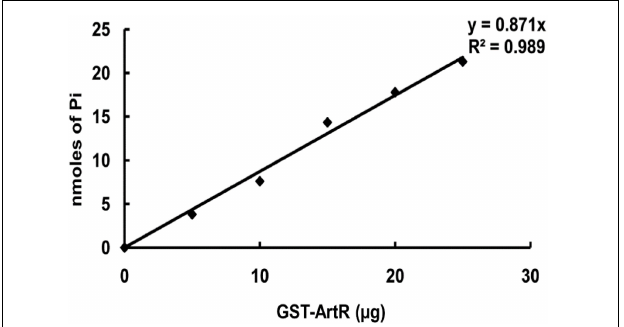
FIGURE 7 | ATPase activity of purified GST-ArtR protein. The ATPase activity of GST-ArtR protein was detected by assaying the amount of inorganic phosphate liberated from ATP using NaH 2 PO 4 as a standard. Purified GST-ArtR protein (0–25 µ g) was added into the reaction mixtures. The reaction was started by adding 2 mM ATP and terminated after 1 h by the addition of the Malachite Green reagent. Purified GST tag was used as negative control and no ATPase activity was